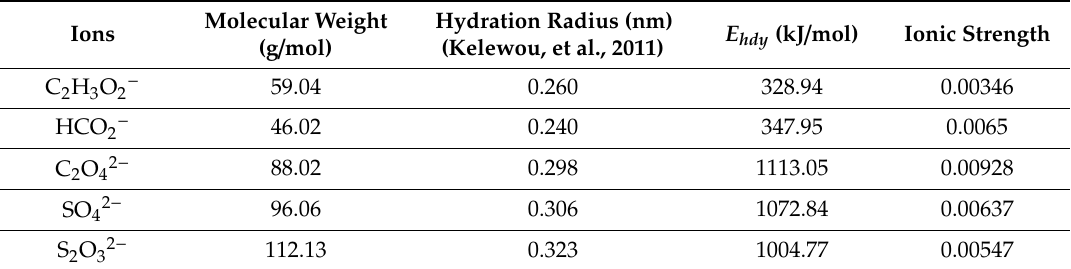
Table 1. Charge, molecular weight, hydration radius and hydration energy of ions used. Molecular Weight Ions